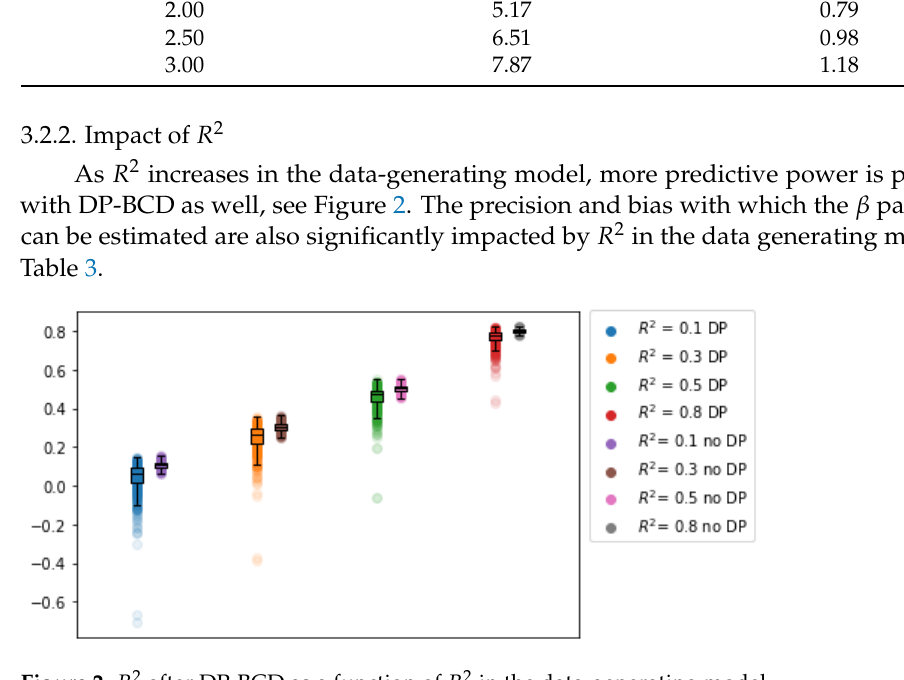
Figure 2. R 2 after DP-BCD as a function of R 2 in the data-generating model. Table 3. Mean and median proportional absolute error over R 2